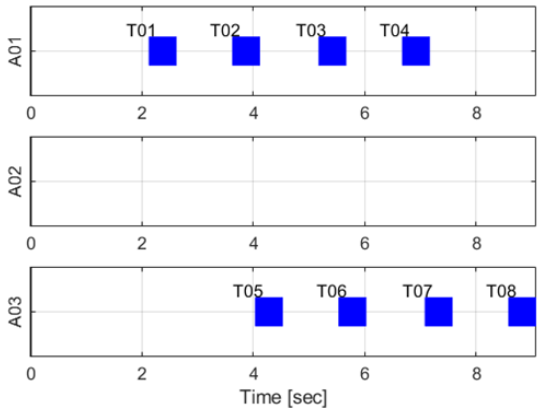
Figure 5. Computational time of TACTAR for a simple case applying an accumulated distance cost scheme.